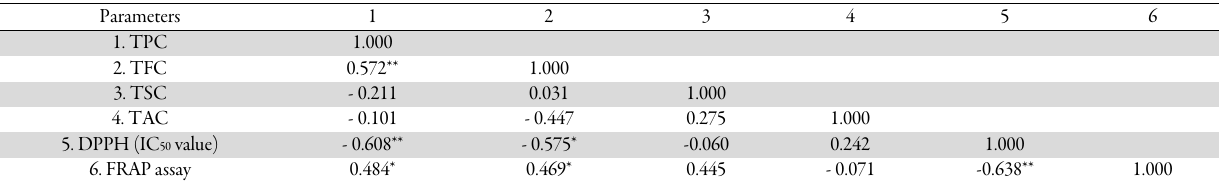
Table 2. Correlation between antioxidant activities (DPPH and FRAP assays) with total phenolic, total flavonoid, total saponin and total